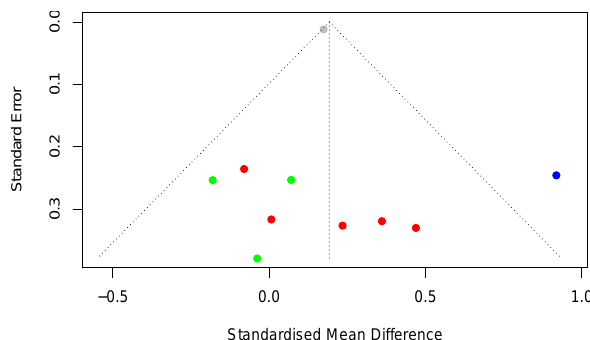
Figure 2. Meta-analysis funnel plot. Red: heritage bilingual (at least one parent speaks ’foreign’ language), tested in majority language. Blue: heritage bilingual, tested in heritage language. Green: minority language (member of non-immigrant minority language group), tested in majority language. Grey: mixed (subjects involve some mix of the other